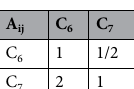
Table 5. Comparative criteria level matrix (Level 2 indicators).